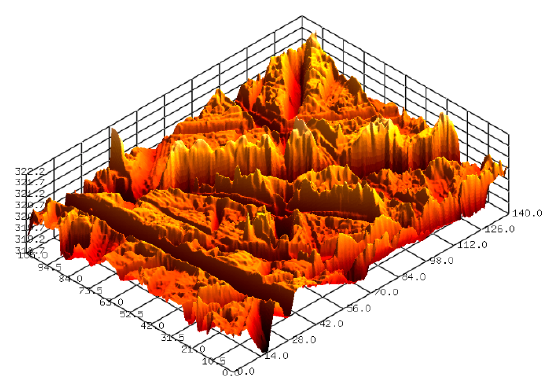
Figure 4. 3D surface profile of SS304 after polishing with 80-grit (#80) sandpaper (Sa 0.391 μ m).